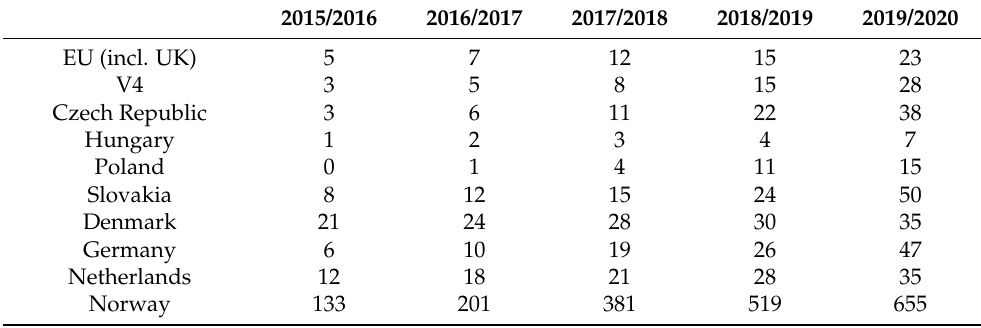
Table 6. The number of fast (the power is at least 22 kW) public charging points per 100 km of highway at the turn of the years, (source: elaborated by authors based on [25]).